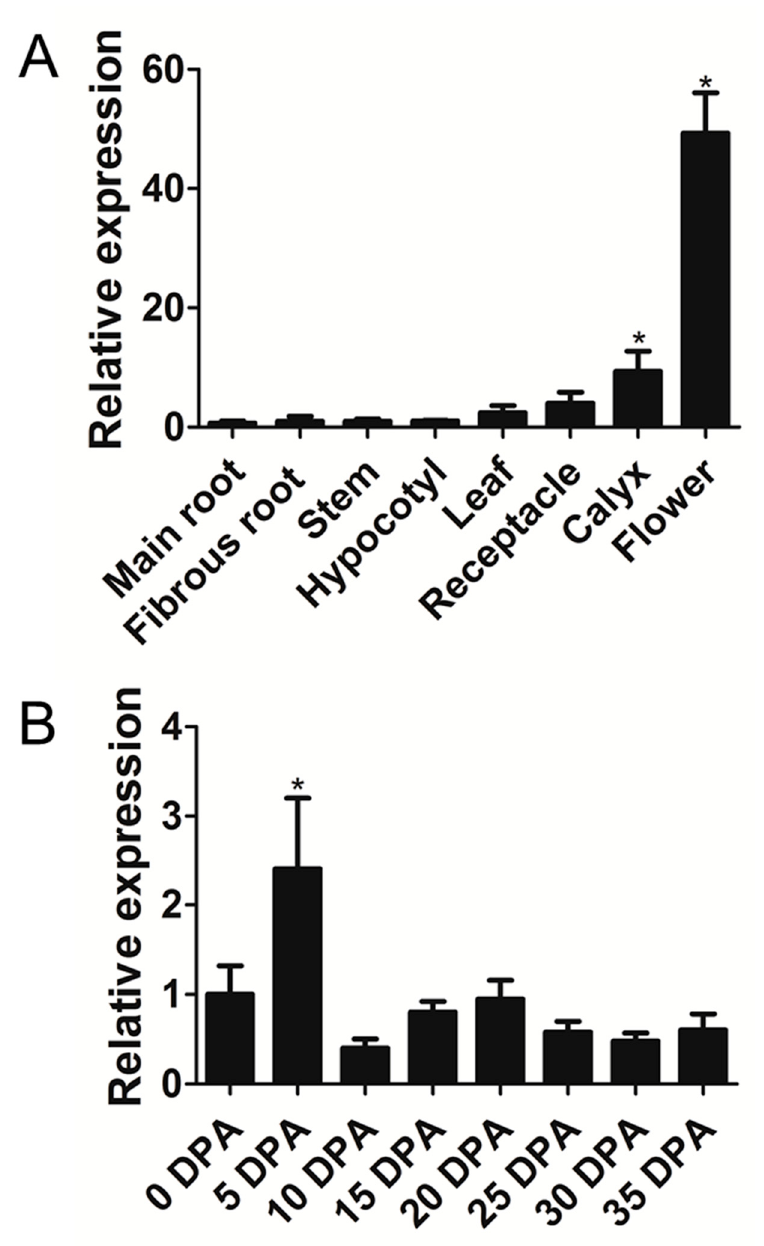
Figure 3. The expression pattern of the GbTCP4 gene in different tissues and fibers at different developmental stages of cotton. ( A ) Transcriptional levels of GbTCP4 in the cotton main root, fibrous root, stem, hypocotyl, leaf, receptacle, calyx, and flower. The transcriptional levels were calibrated by the control (hypocotyl) ( B ) Transcriptional levels of GbTCP4 in developing cotton fibers collected at 0 (ovule), 5, 10, 15, 20, and 25 d post anthesis (DPA). The transcriptional levels were calibrated by the control (0 d days post anthesis (DPA)). GbUBQ7 is used as an internal reference gene. Values represent the means of three biological replicates, and error bars represent standard deviations. Asterisks indicate a significant difference (* p < 0.05) relative to the corresponding controls.